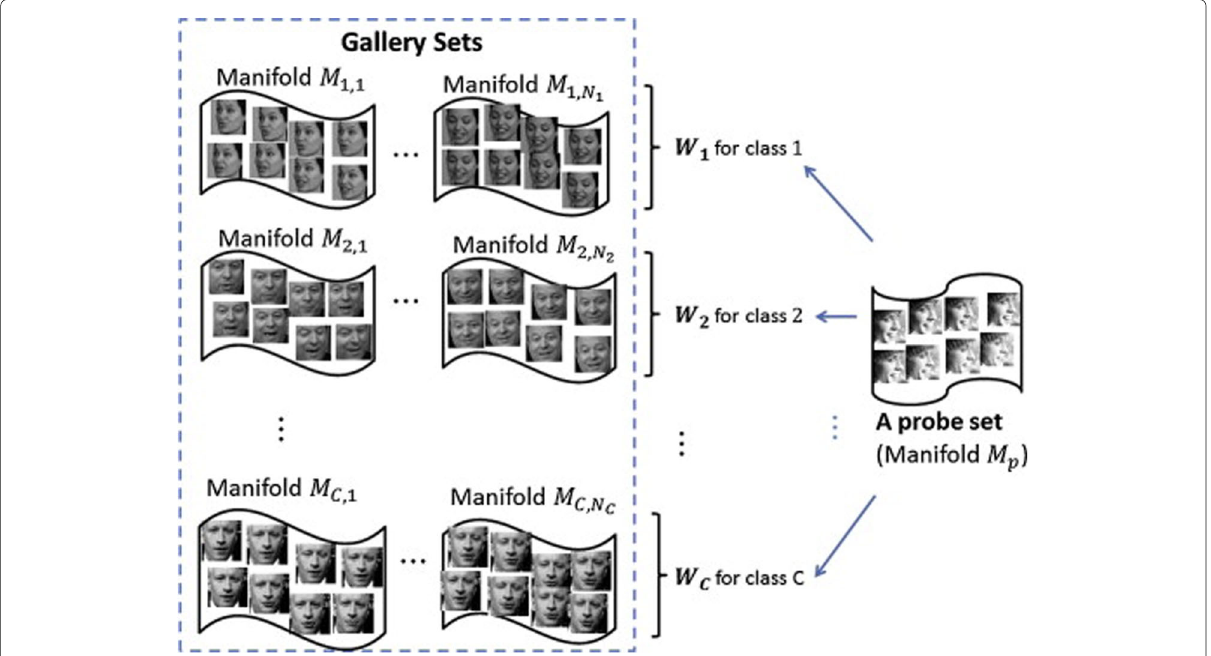
Fig. 7 Multi-manifold metric learning, originally shown in